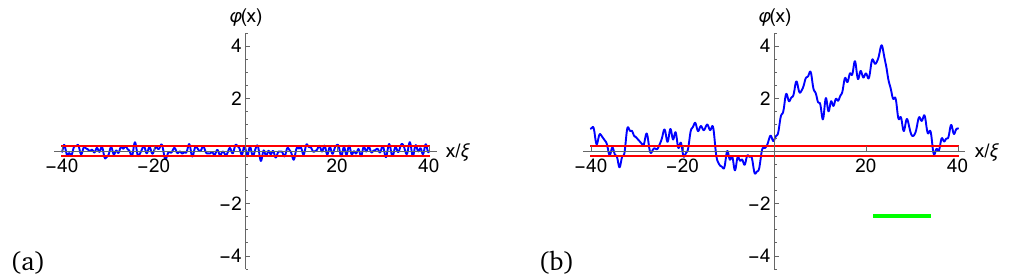
( x , t ) for the phase field Figure 1: Individual realizations of the eigenvalue ϕ a 0 ˆ φ ( x , t ) . The typical behavior at t = 0 ξ/ v , cf. (a), is distinctly different from a 0 0 = 14 ξ/ v , cf. (b). At t = 0, small fluctuations occur at all length scales, that at t (cid:112) 0 0 K (red lines). At later times, the typical fluc- with a typical amplitude given by 1 / tuations are larger for longer length scales. The crossover length scale from which fluctuations become large is indicated with a green bar. In terms of Luttinger Liquid = 8 K 2 /ρπ 2 . A further note about experi- parameters, it is predicted [ 36 ] to be l 0 mental parameters is presented in Section